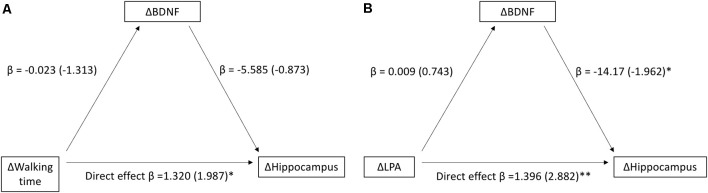
Relationship between changes in walking time and Hippocampus (A) and changes in light-intensity physical activity (LPA) and Hippocampus (B) between baseline and 13 months, as mediated by changes in BDNF between baseline and 13 months. Beta-values along with standardized coefficients (z-values within parentheses) are reported, *p < 0.05, **p < 0.01.